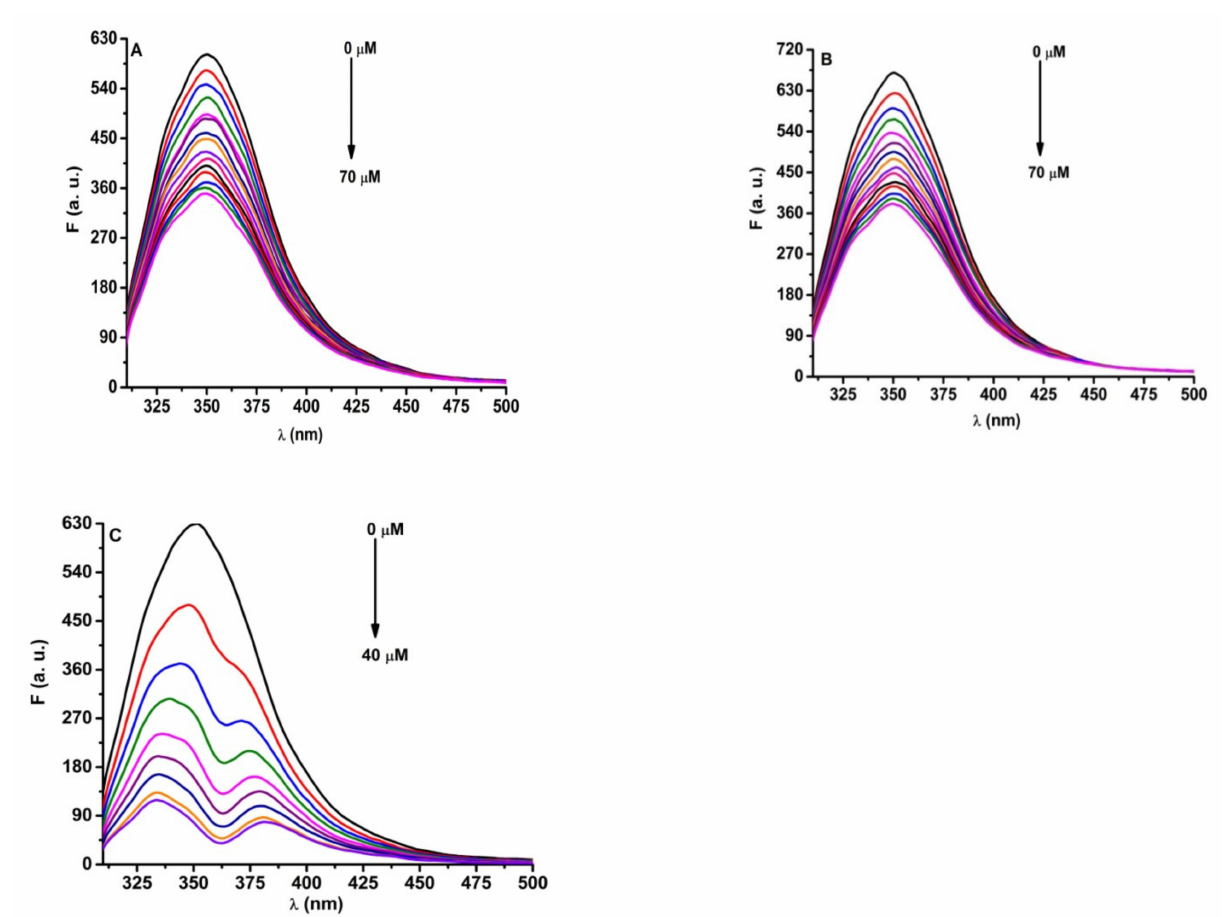
Figure 2. Fluorescence emission spectra of BSA-LT4 in the absence and presence of vitamin C ( A ), folic acid ( B ), and vitamin B12 ( C ) at 25 ◦ C. All samples were prepared in 100 mM HEPES buffer, at pH 7.4. The significance of the colors is explained by the arrow in the figure that indicates the direction of increase of the concentration of each compound in the 3 situations.